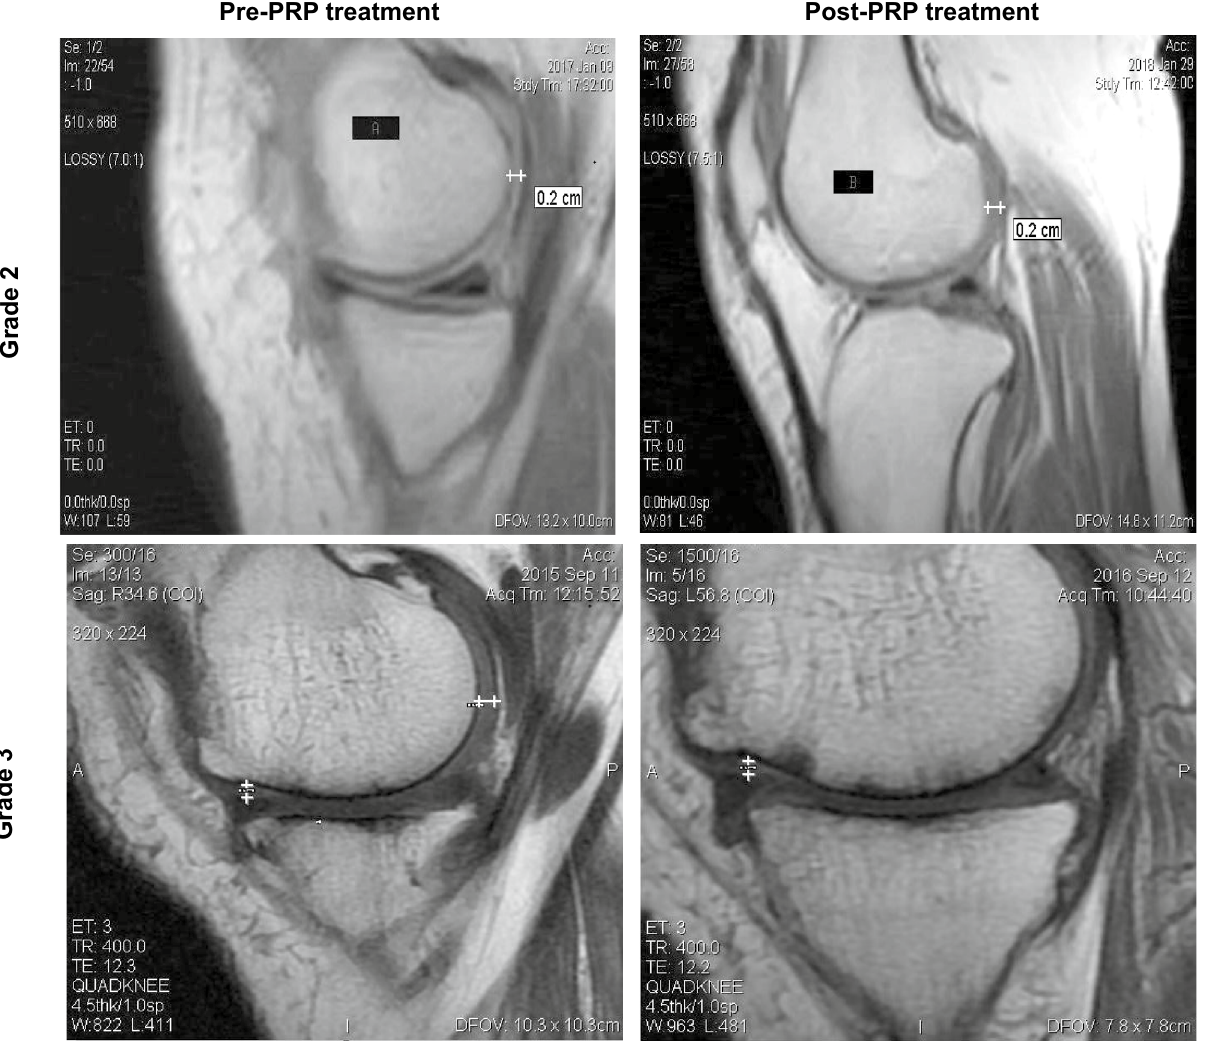
Figure 3. Evaluation of articular cartilage thickness using MRI after one year of PRP treatment in patient with grade 2 and grade 3 OA